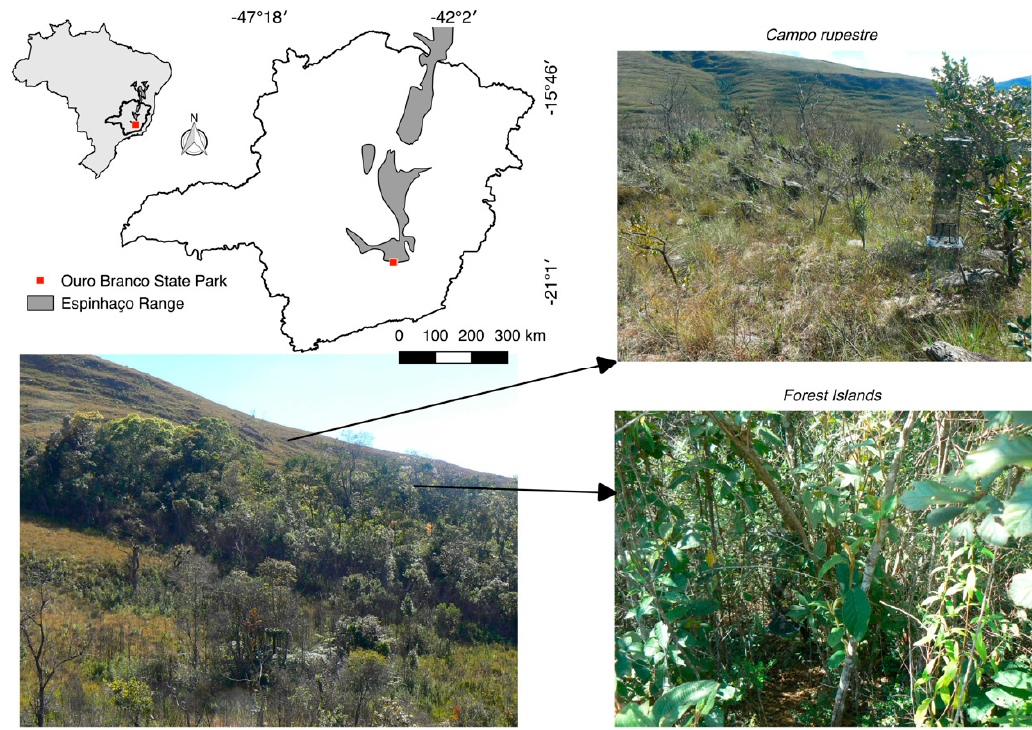
Figure 1. Mountaintop environment at Espinhaço mountain range from Serra do Ouro Branco State Park (20°31 ′ S, 43°41 ′ W) studied.